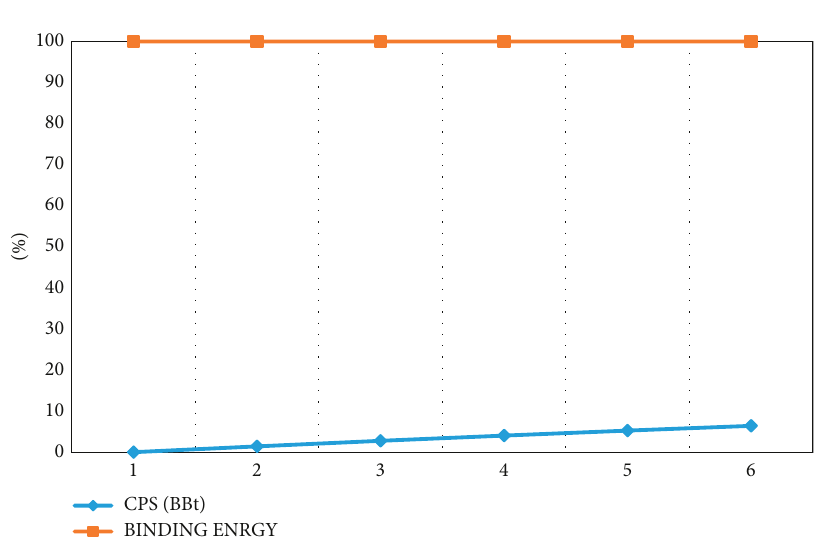
Figure 6: Apparent light for 3